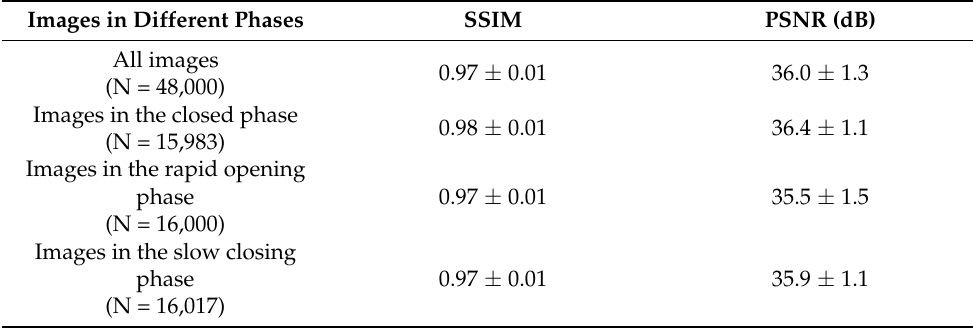
Table 6. Evaluation results of SSIM and PSNR (N: the number of images, mean ± std). Images in Different Phases